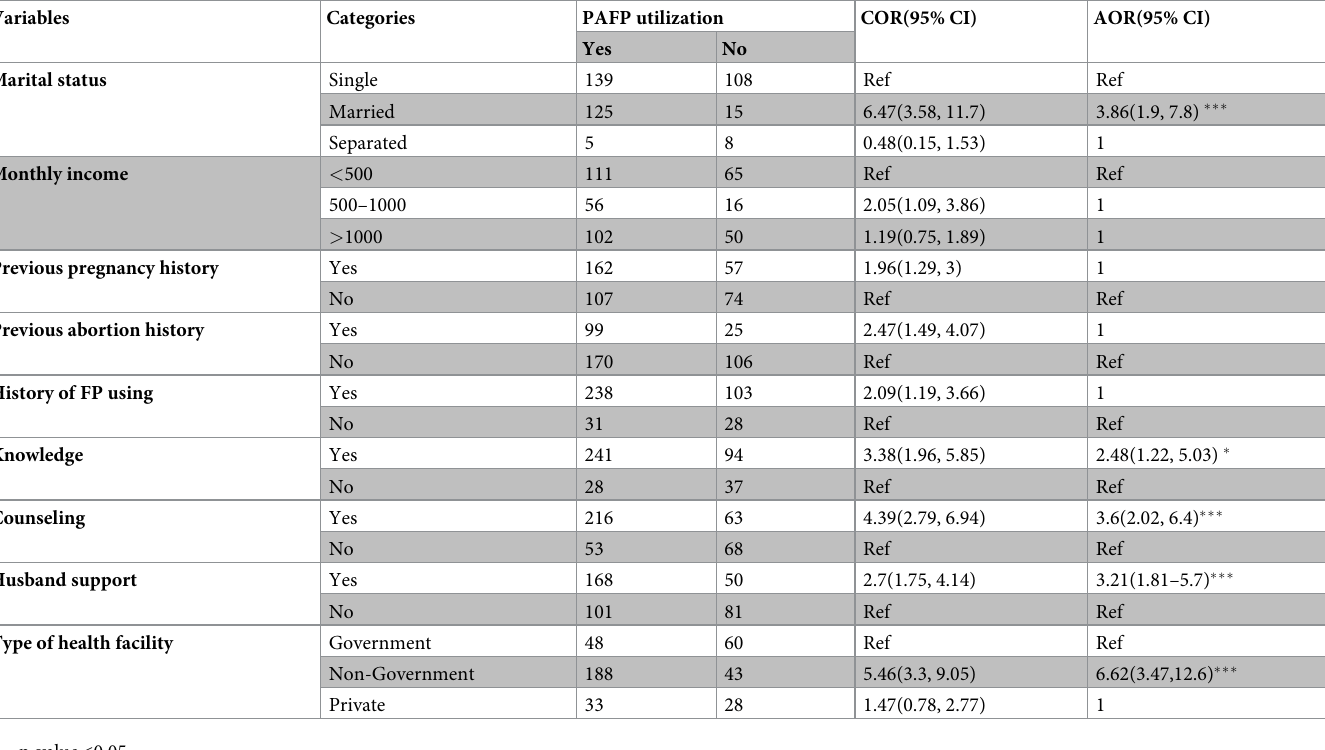
Table 4. Factors associated with PAFP utilization among post-abortion clients in health facilities in Wolaita Sodo town, 2019.